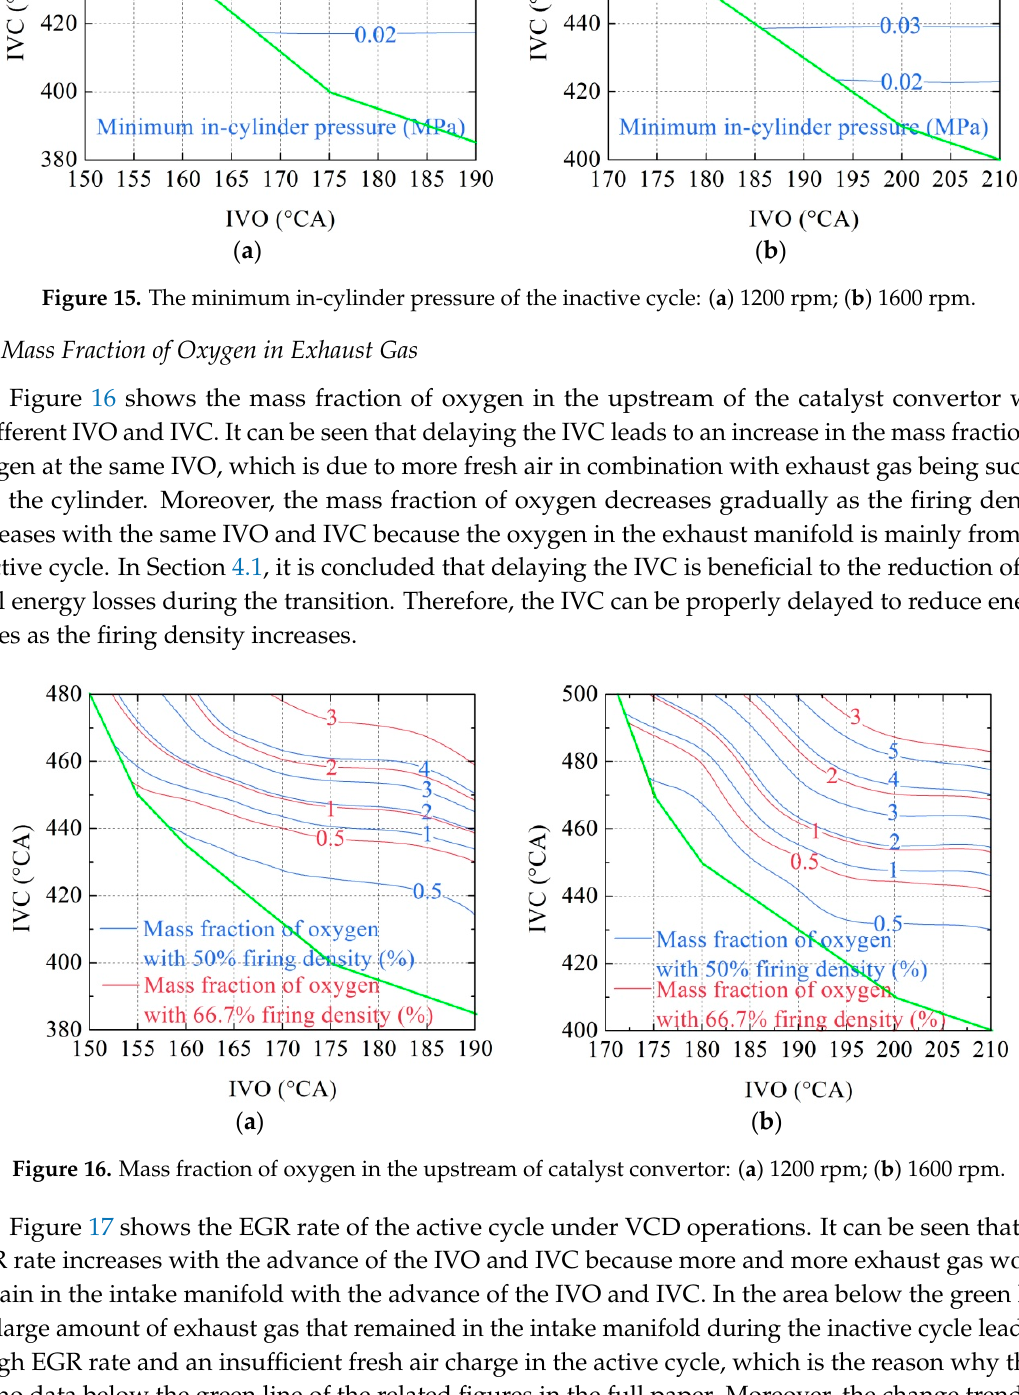
Figure 15. The minimum in-cylinder pressure of the inactive cycle: ( a ) 1200 rpm; ( b ) 1600 rpm.